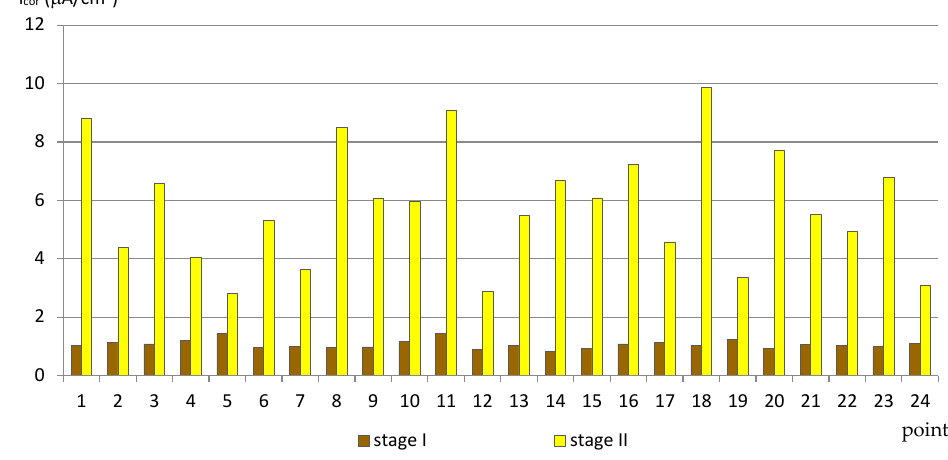
the reinforcement in the studied areas.